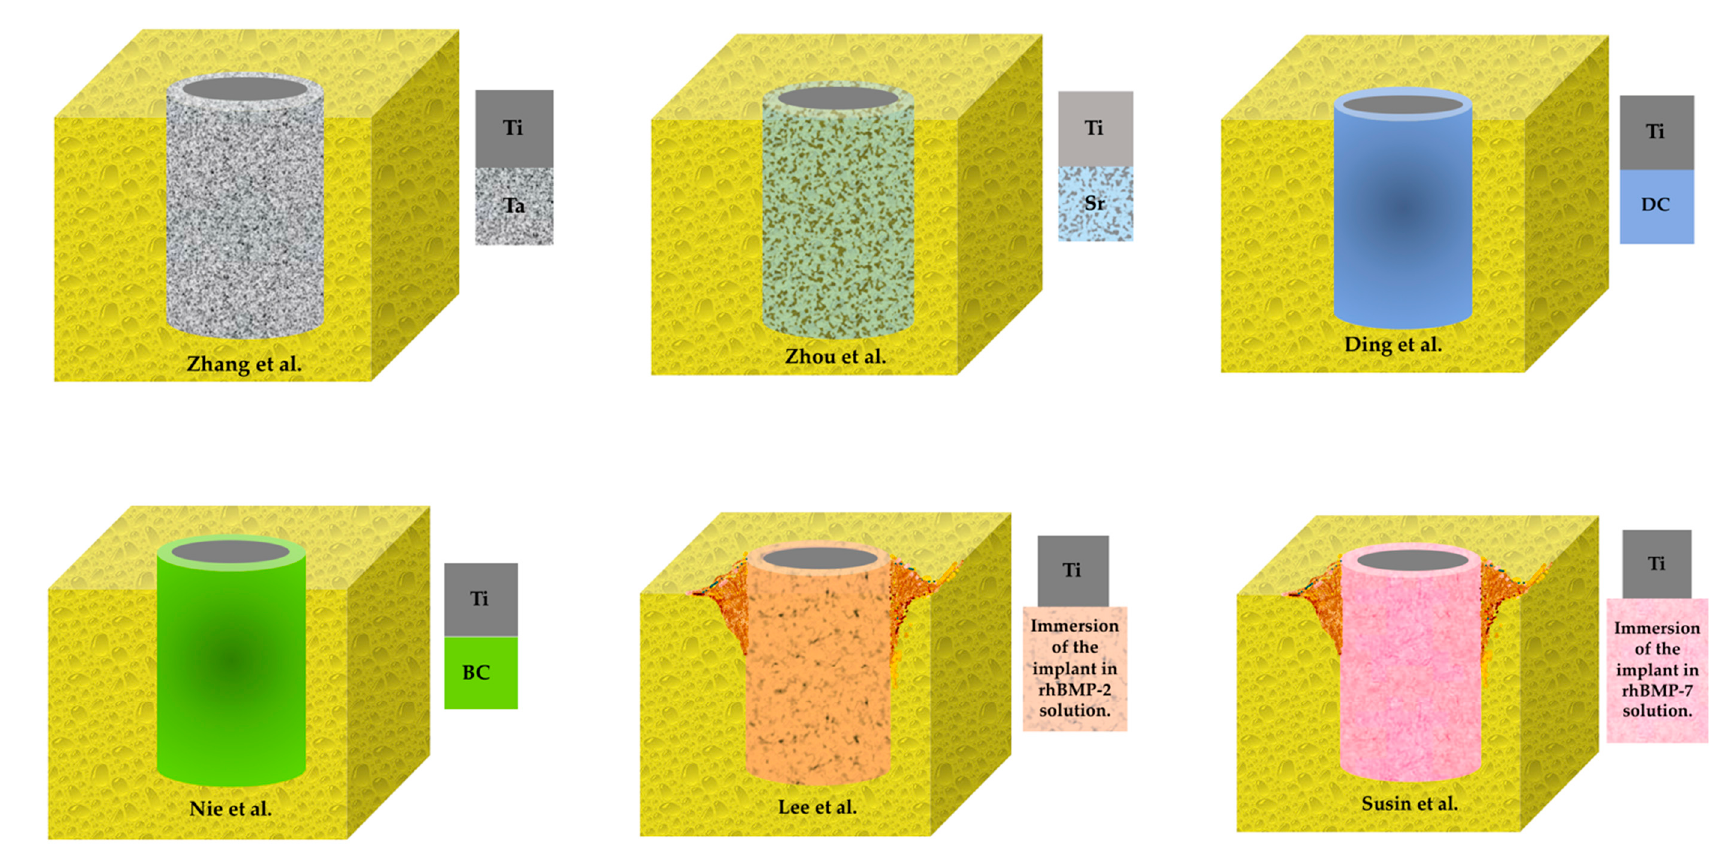
Figure 3. Graph of the incorporation of antibacterial surfaces to Ti-implants in included studies. Ti, titanium; Ta, tantalum; Sr, strontium; DC, doxycycline; BC, bacitracin; rhBMP, human bone morphogenetic protein.